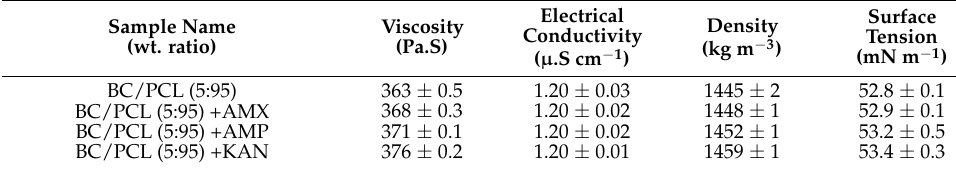
Table 1. Physical properties of EHD-3D printed solutions. (Mean ± SD, n = 3). Sample Name (wt.